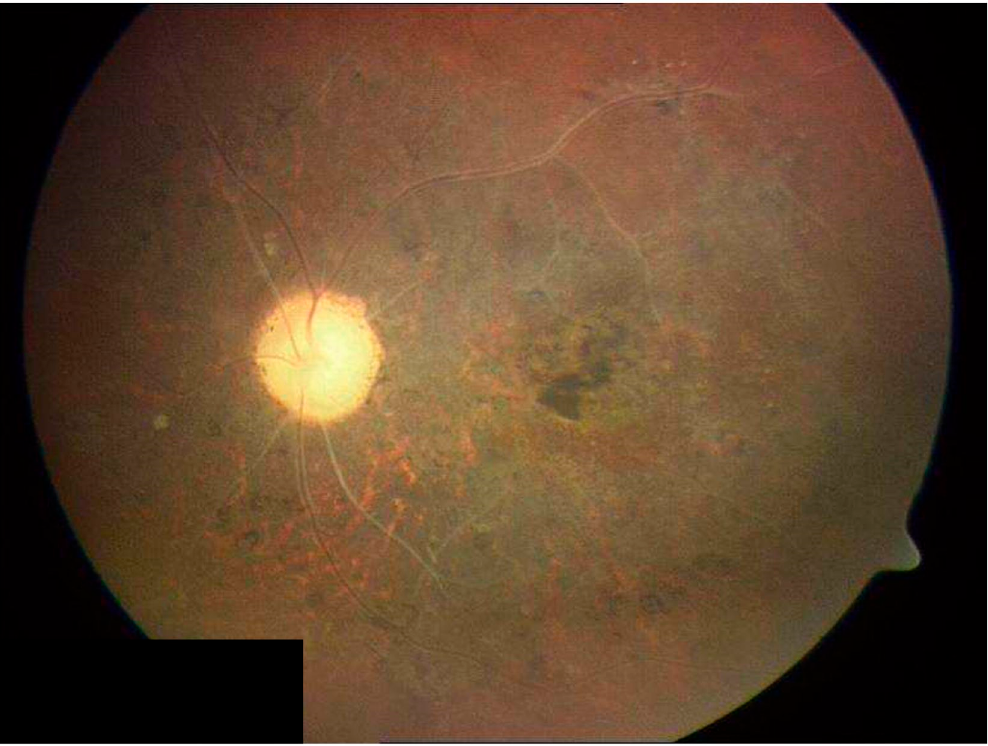
Figure 9. Fundus photograph of a 32-year-old patient with Behcet’s syndrome (only left eye shown) demonstrating occlusive retinal vasculitis leading to severe retinal and optic nerve atrophy. There is severe macular atrophy as well.